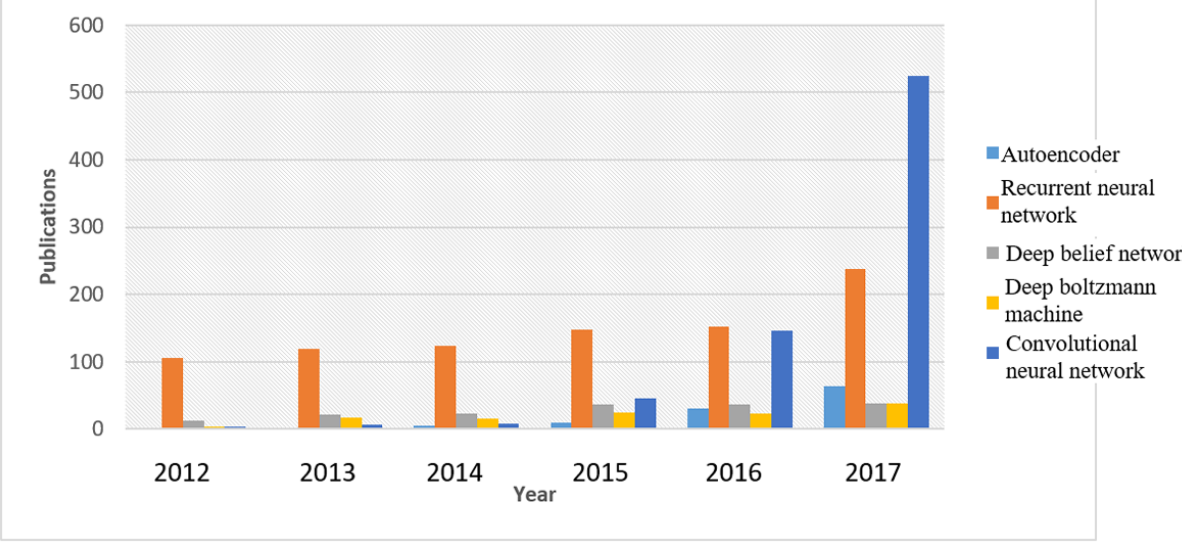
Figure 12. Research publications in different category of deep learning methods. These statistics are obtained from PubMed database by searching for publications containing any of the deep learning method in title or